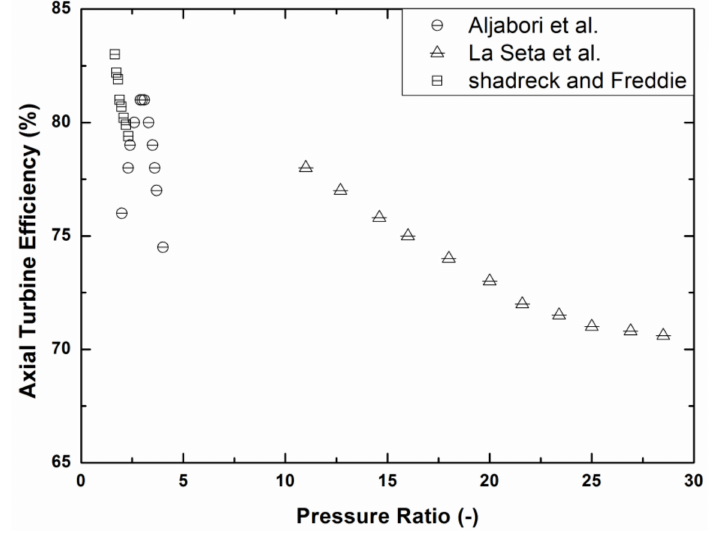
Figure 10. Performance of axial